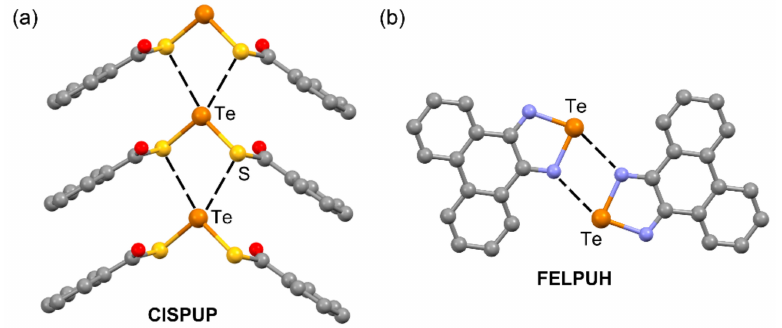
Figure 15. Ball-and-stick representation of the X-ray solid-state structures of CISPUP ( a ) and FELPUH ( b ), where the ChBs are represented using dashed lines. H atoms omitted for clarity. Table 6. CSD codes, ChB donor (Ch) and acceptor (A) atoms, intermolecular distance (d Ch ··· A in Å), and X–Ch ··· A (X = N, O, and S) angle ( ∠ in ◦ ). CSD